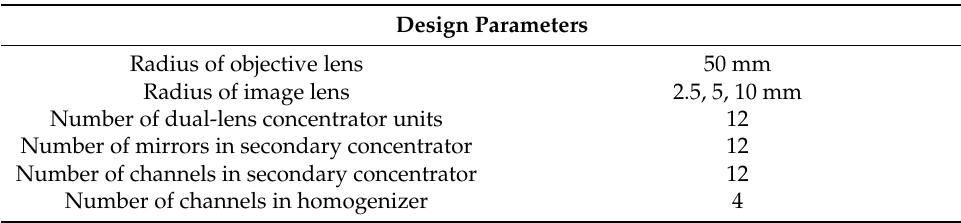
Figure 8. Ray-tracing analysis of the proposed HCPV system using LightTools TM software (Version 9.0, Synopsys, Inc., Mountain View, CA, USA), indicating that a wide incident beam concentrated through the primary concentrator, guided through the secondary concentrator, and redistributed through the homogenizer. Table 1. The specifications of our proposed HCPV system. Table 1. The specifications of our proposed HCPV